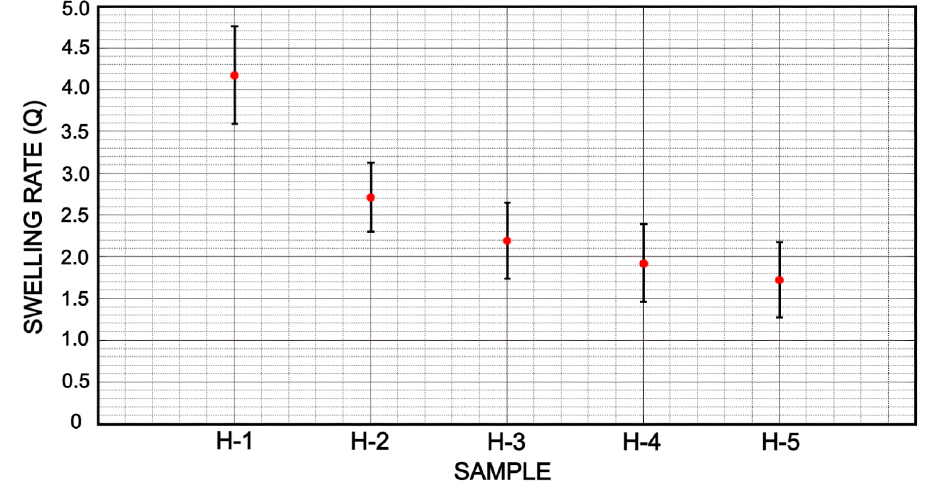
Figure 11. Swelling ratio indicates a greater capacity to retain liquid in hydrogels that have a lower amount of cross-linking agent, such is the case of H-1 and H-2 samples. On the other hand, a higher swelling rate can lead to greater wear of the hydrogel chains and make it less